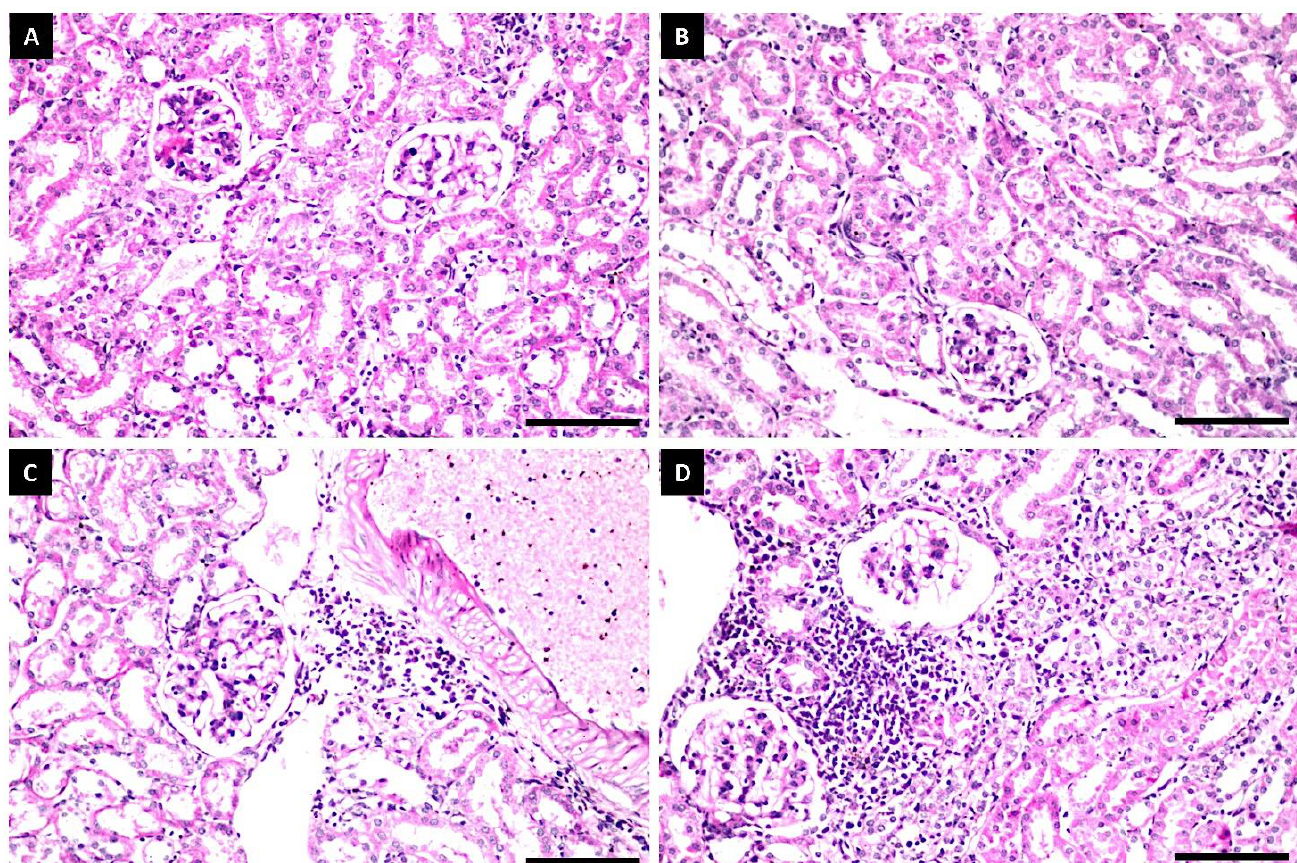
Figure 7. Histopathological changes in the kidney of male albino rats fed with grain sorghums treated with Fe 3 O 4 /HA NPs; no histopathological alteration in the glomeruli and tubules at the cortex were recorded in untreated and treated rats with 10 mg L − 1 ( A , B ); few focal inflammatory cells infiltration was detected in between the sclerotic dilated blood vessels, glomeruli and tubules of rats exposed to 40 mg L − 1 Fe 3 O 4 /HA NPs ( C ); focal massive inflammatory cell aggregation in between the degenerated necrosis tubules as well as vacuolization in the endothelial cells lining the glomeruli of rats exposed to 80 mg L − 1 Fe 3 O 4 /HA NPs ( D ). Scale bar represents 100 µ